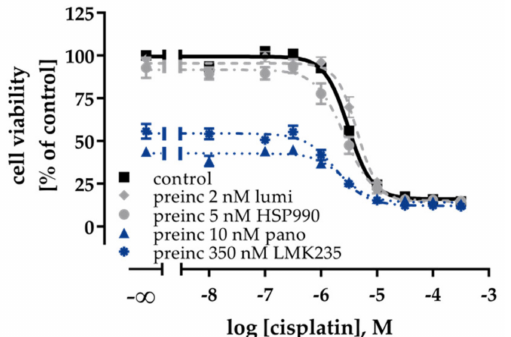
Figure 7. 48 h preincubation with luminespib, HSP990, panobinostat or LMK235 prior to 72 h cisplatin treatment did not a ff ect cisplatin sensitivity of the non-cancerous cell line HEK293. Data shown are mean ± SEM of three independent experiments. Results (IC 50 , pIC 50 , SEM, and shift factors) are summarized in Table